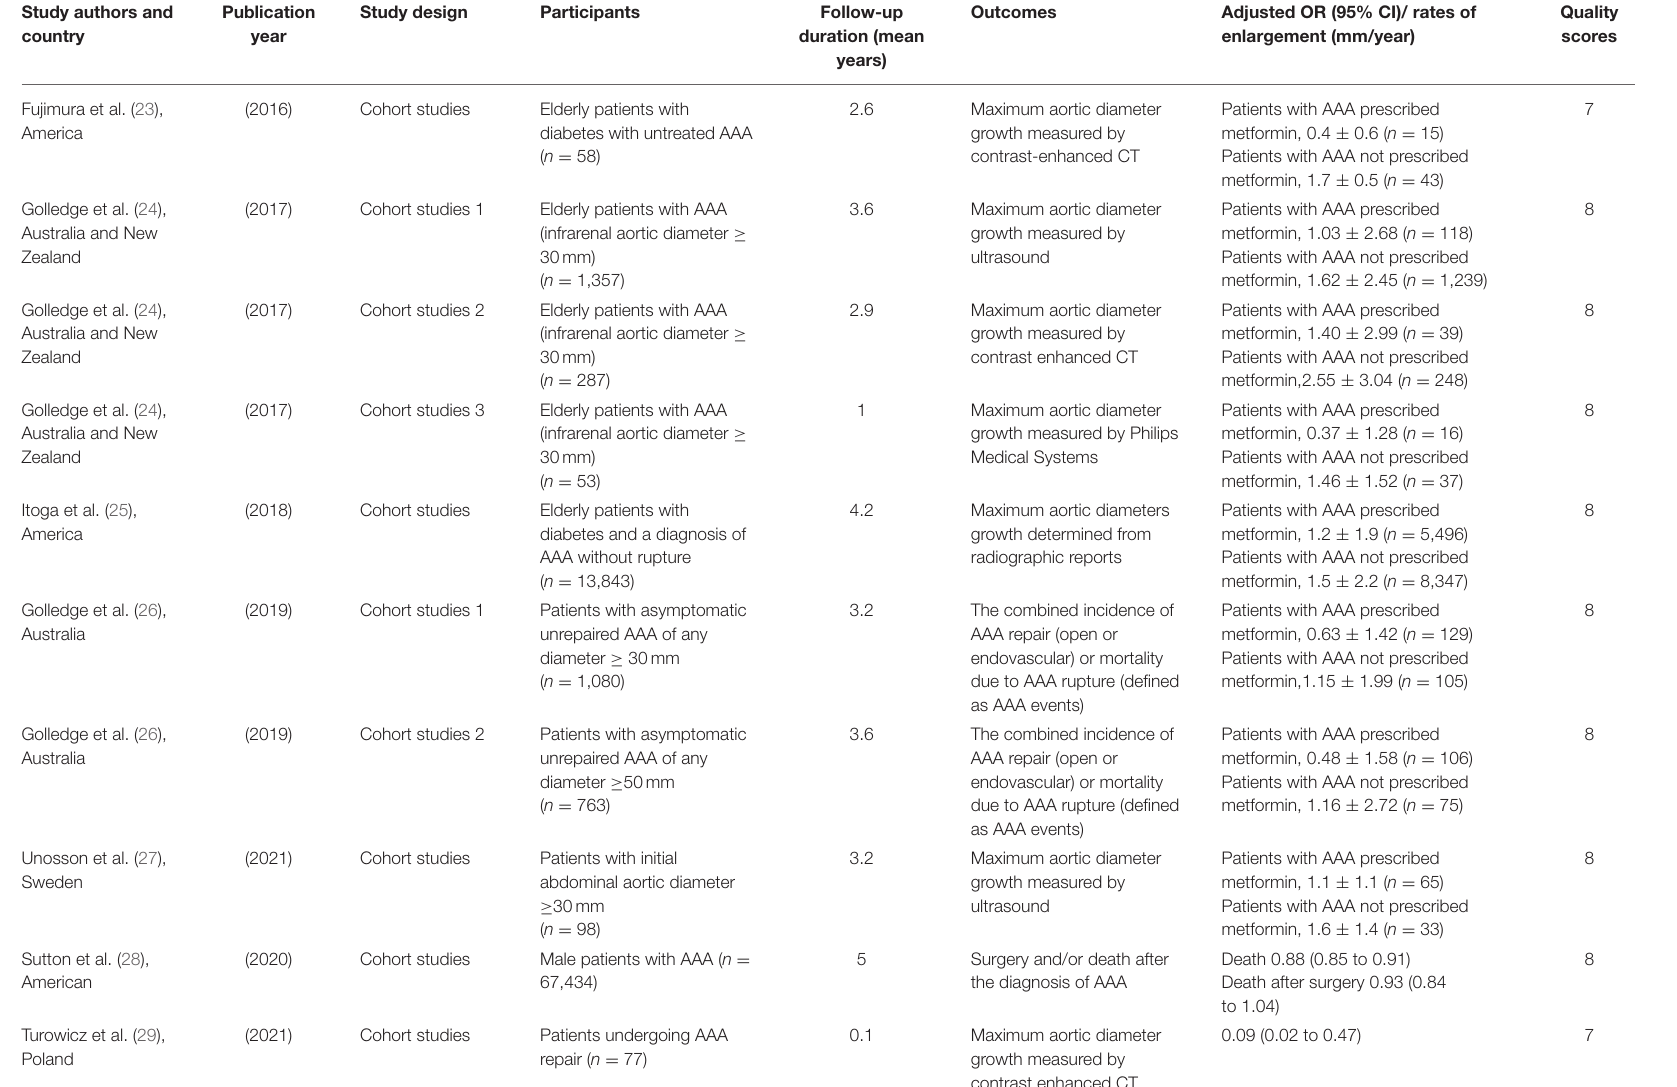
TABLE 1 | Characteristics of the included